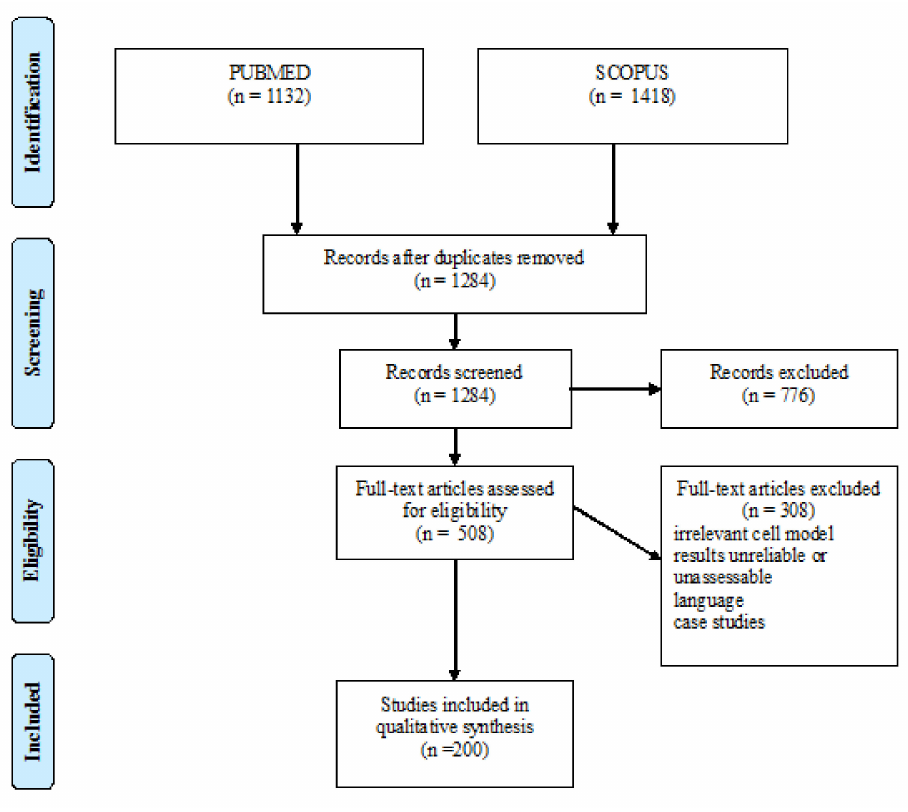
Figure 1. PRISMA flow